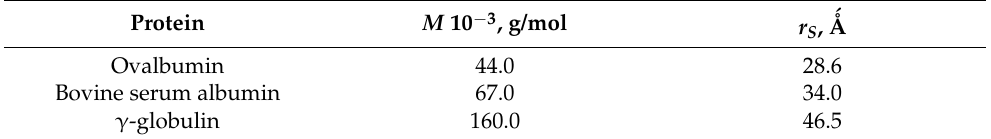
Table 1. Molecular weights ( M ) and Stokes radii ( r S ) of protein molecules. Protein